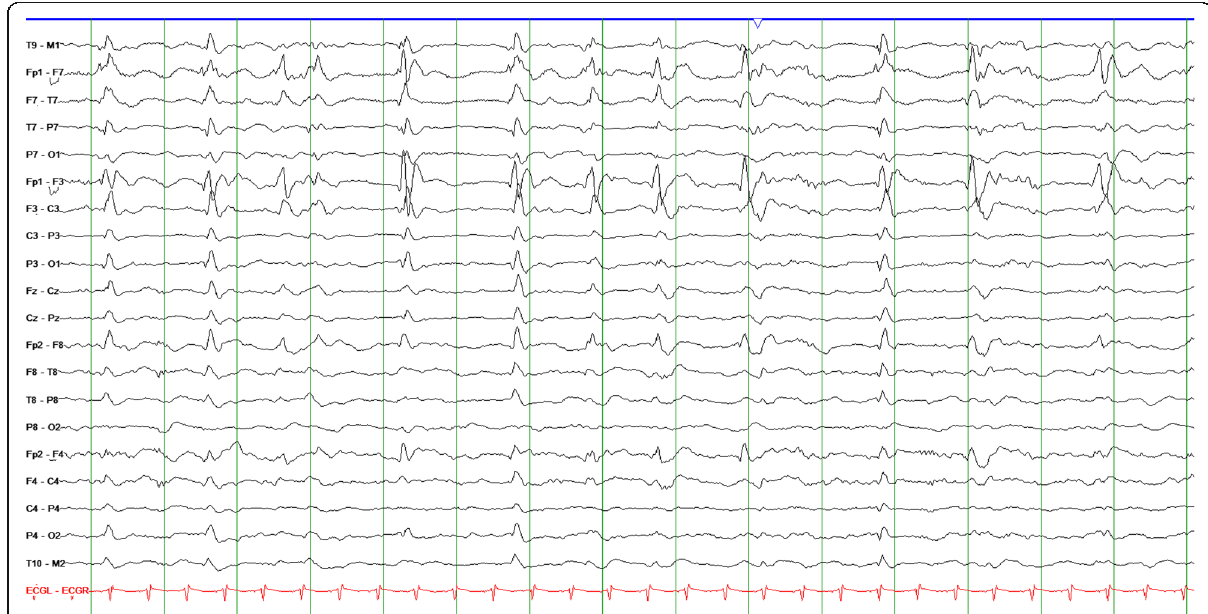
Fig. 1 Lateralized periodic discharges (LPDs) at a frequency of approximately 1Hz in a patient with hemorrhagic stroke in the left fronto-temporal region. High pass filter 1Hz, low pass filter 50 Hz and sensitivity